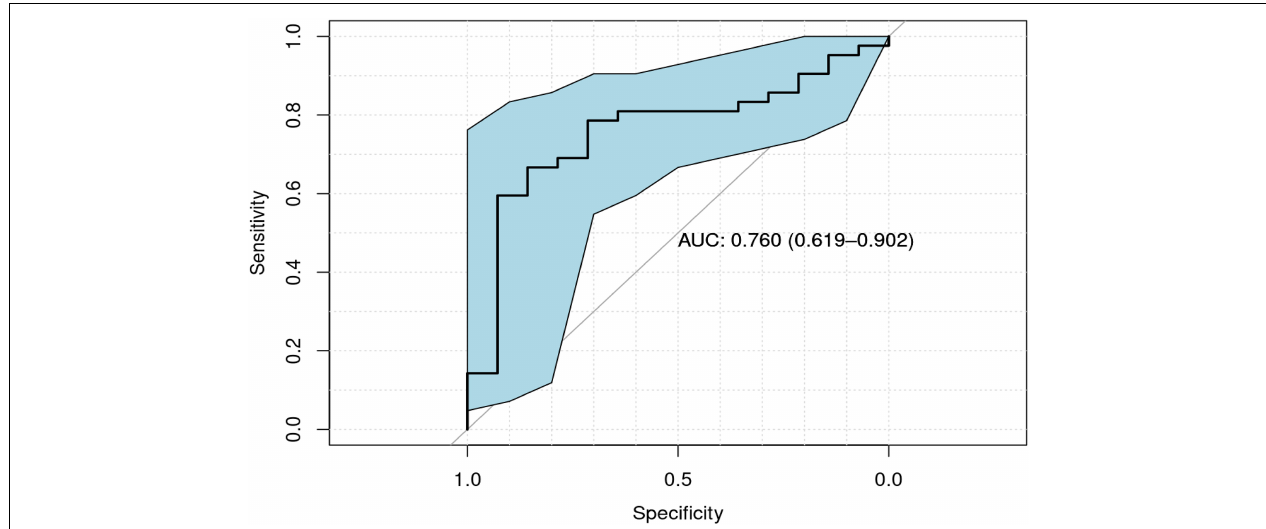
FIGURE 1 | ROC curve of serum Se values for cases vs. controls among males, along with confidence interval regions for sensitivity over a grid of specificities (indicated in shaded blue region). An estimate of the AUC and its 95% confidence interval (in parentheses) is also